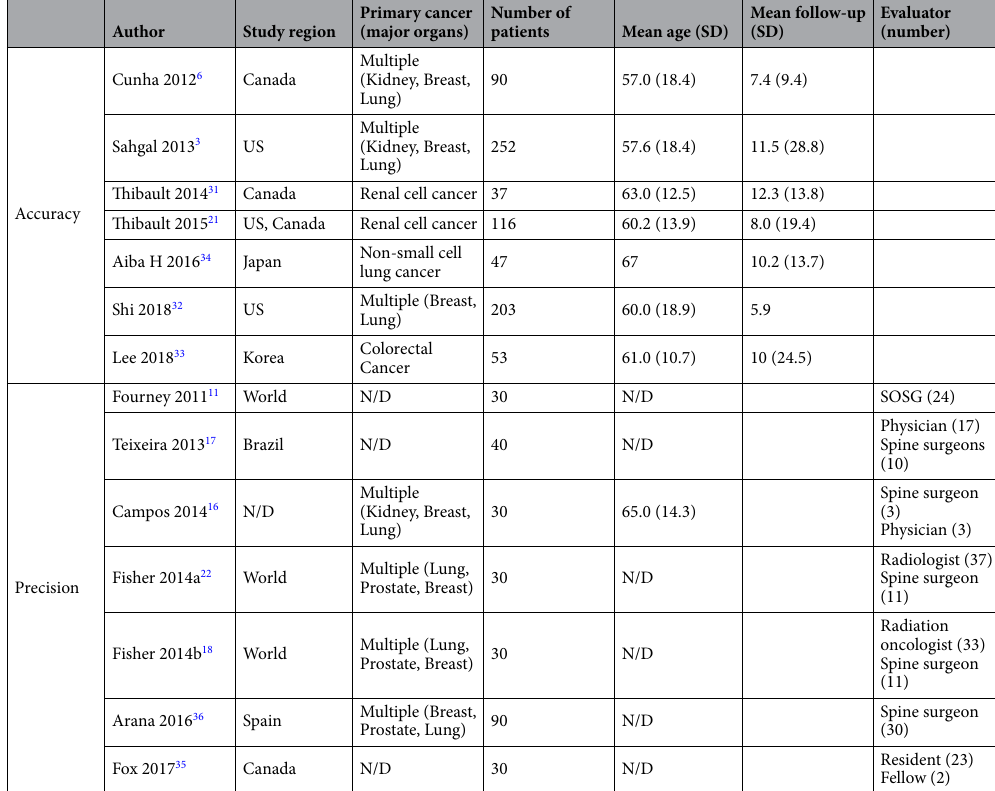
Table 2. Baseline characteristics of enrolled studies. SD standard deviation, N/D not described, SOSG the spine oncology study group.